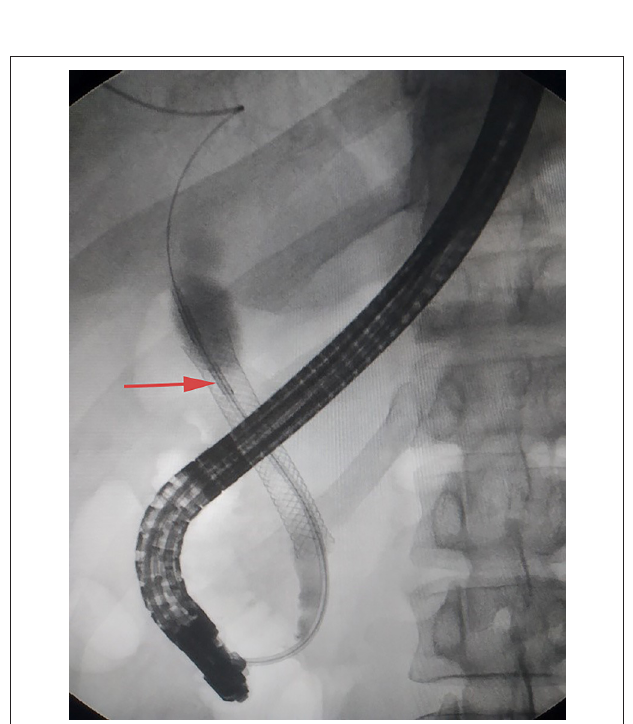
FIGURE 6 | Radiofrequency ablation in the same plane with SpyGlass DS.